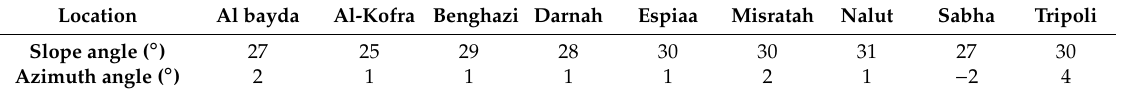
Table 10. Optimum angles for the PV system for all selected